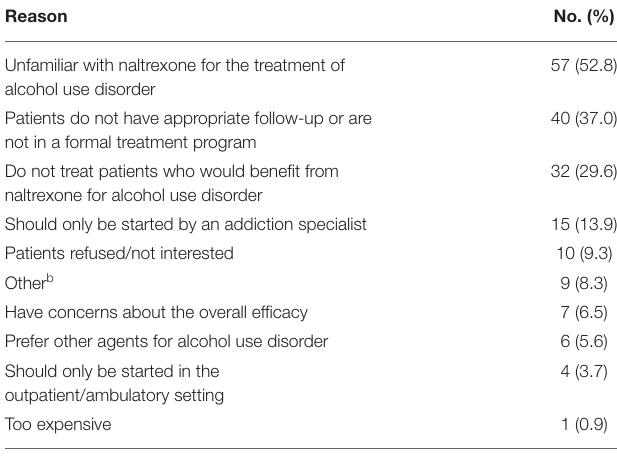
TABLE 2 | Reasons for not prescribing naltrexone ( n = 108) a